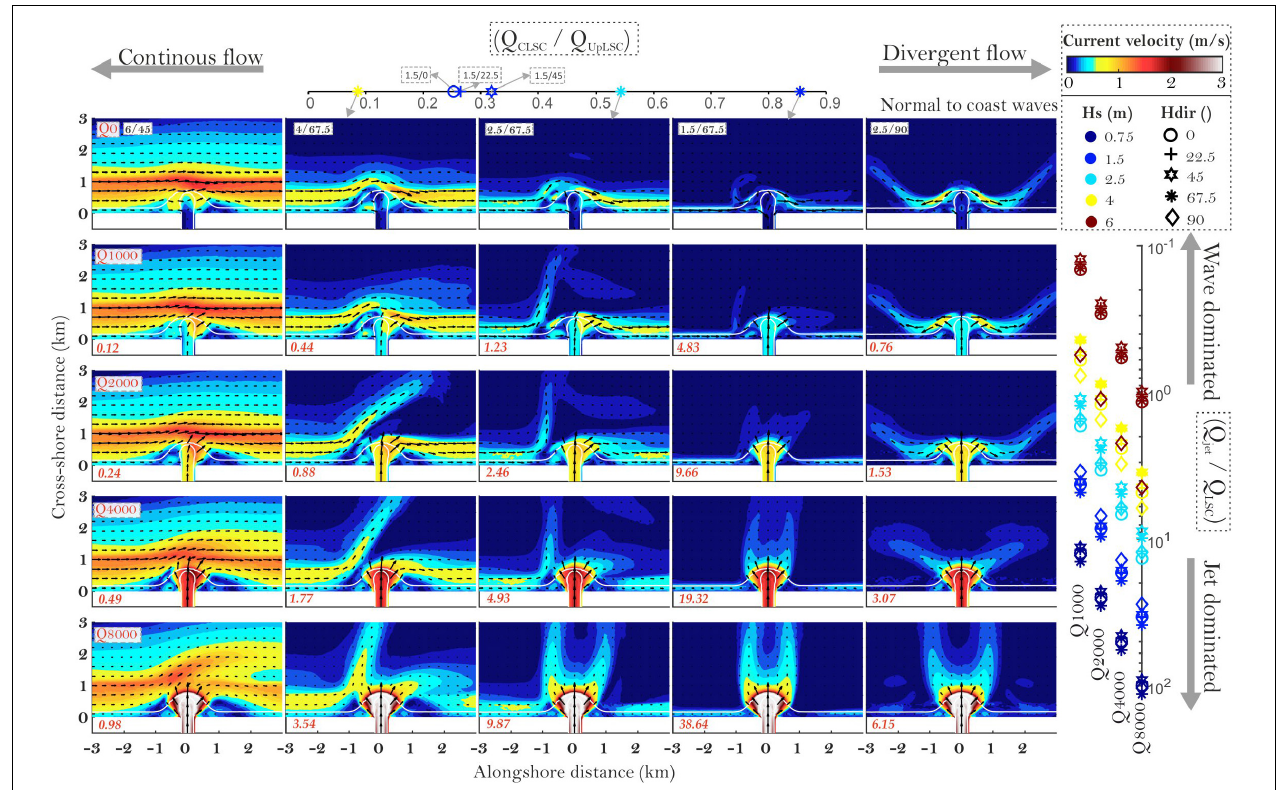
FIGURE 8 | Circulation patterns for the Small RMB case with a selection of wave heights, directions, and river discharges. Values in left bottom corner of each plot show the Q Jet / Q LSC